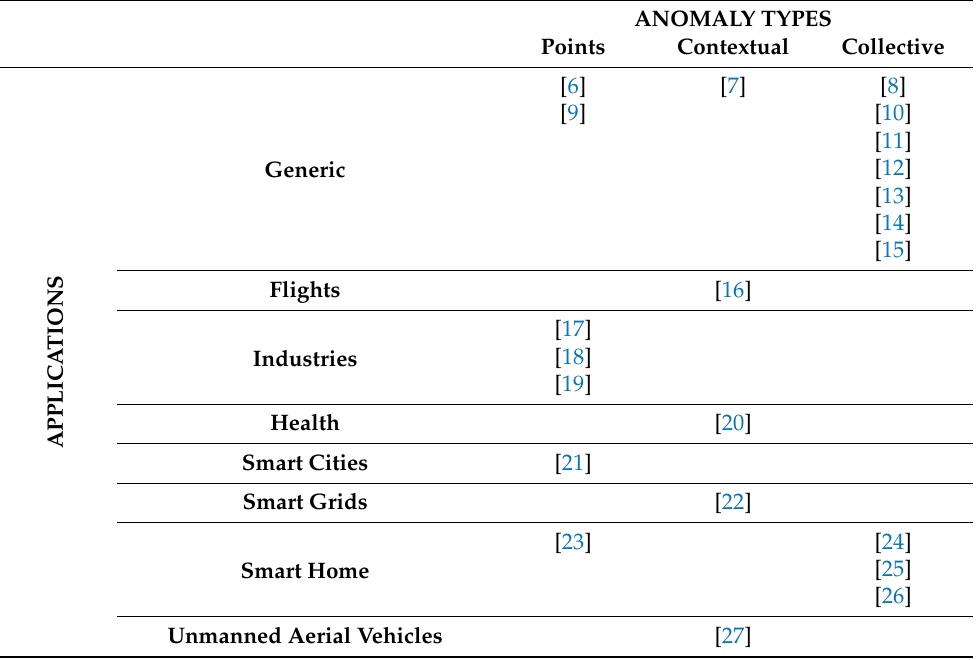
Table 1. Anomaly-Based I.D.S.s according to Anomaly Types and